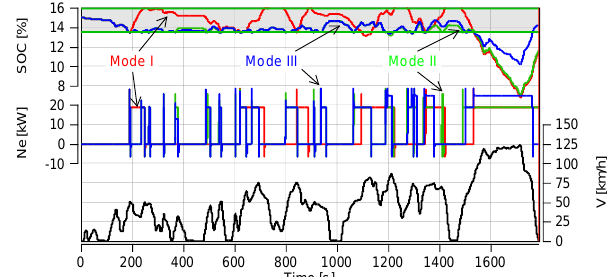
Fig. 10. Changes in SOC and internal combustion engine power in the WLTC test The assessment of energy consumption (Fig. 11) shows